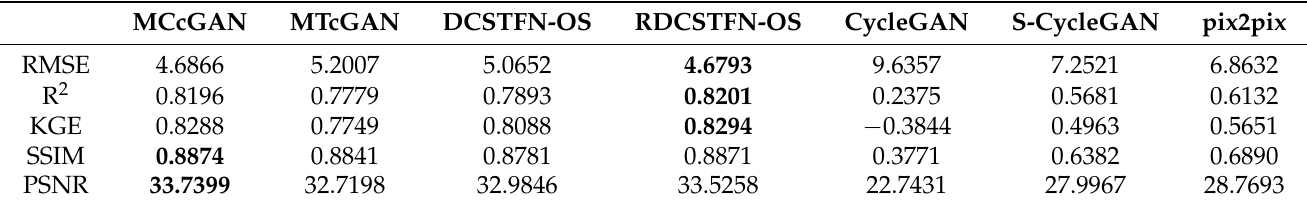
Table 5. The evaluation metrics of different methods for the blue band in Area A at Time II (the bold result is the best among the different metrics).